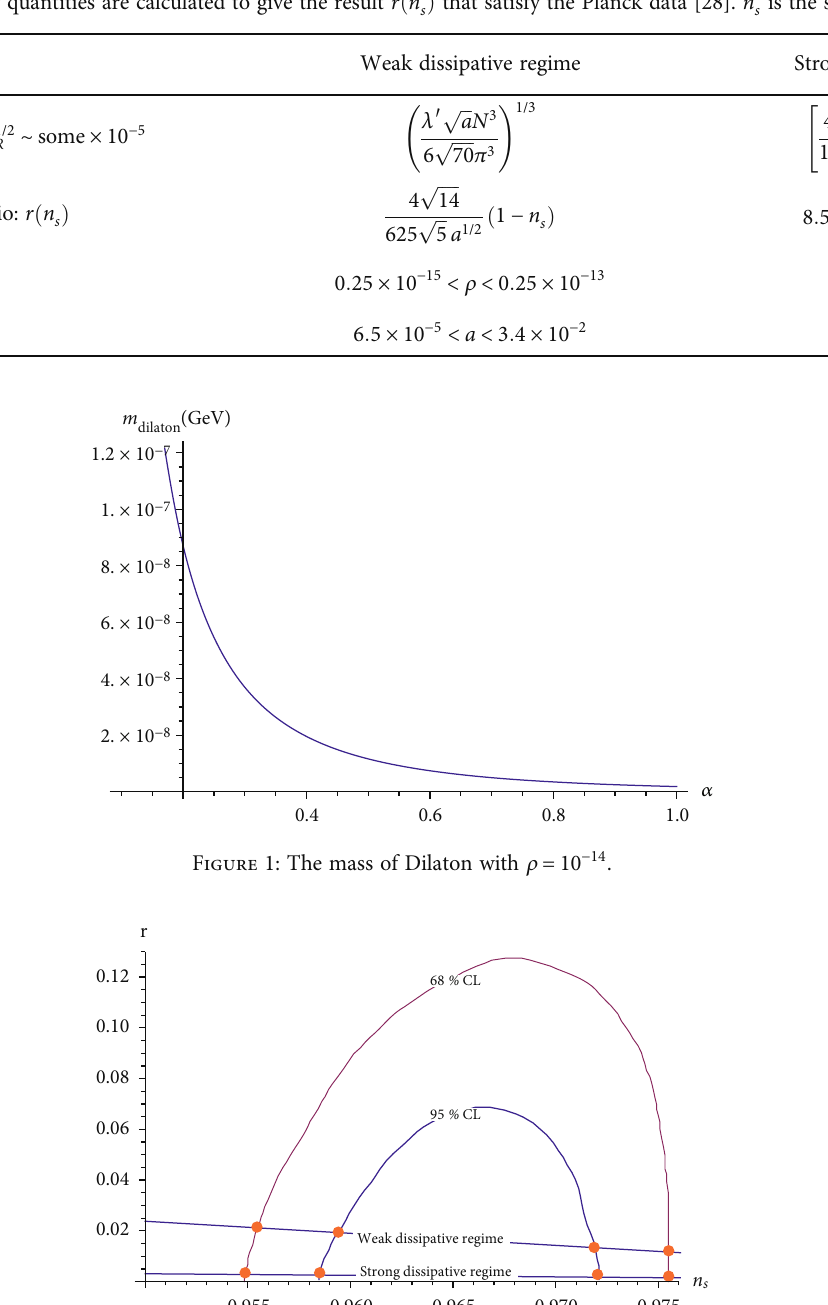
Þ that satisfy the Planck data [28]. n s